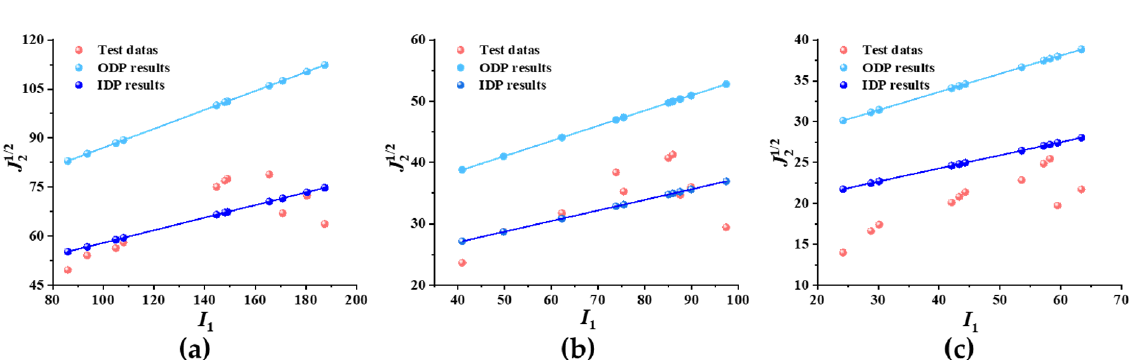
Figure 16. Failure criterion data and theoretical solutions of Drucker–Prager criterion in J (cid:2870)(cid:2869)/(cid:2870) - I (cid:2869) space: ( a ) granite, ( b ) marble, and ( c ) sandstone.